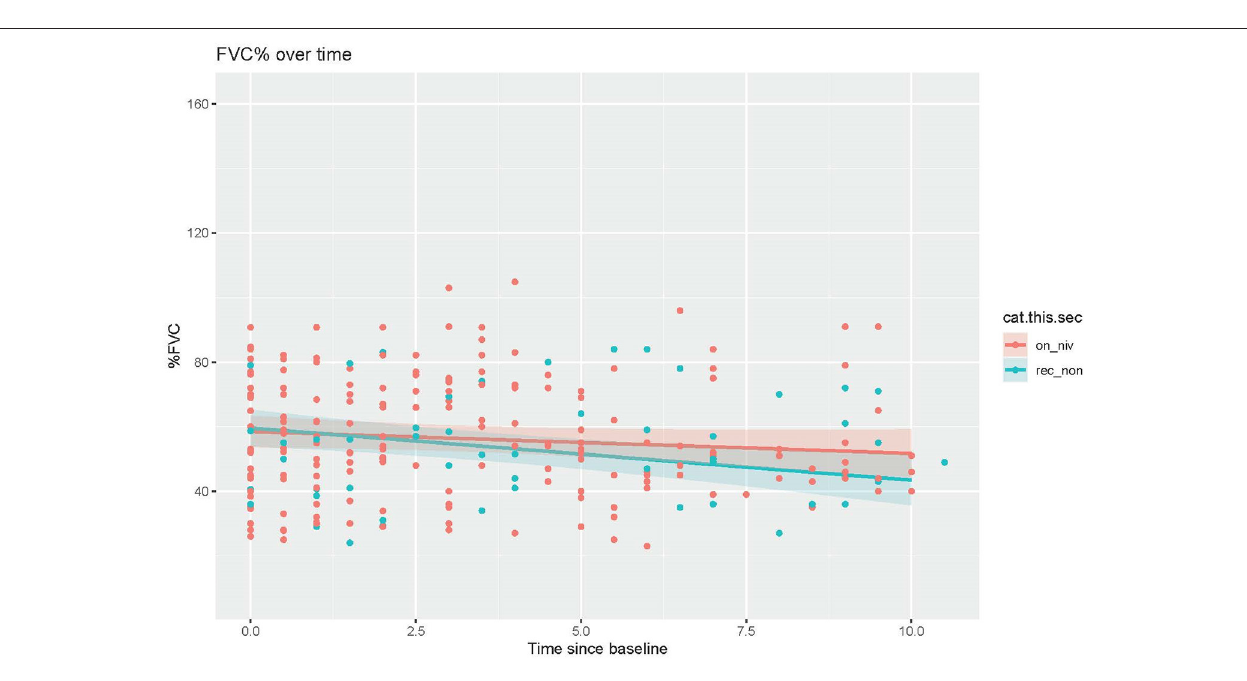
Data on the benefit of NIV use in DM1 is